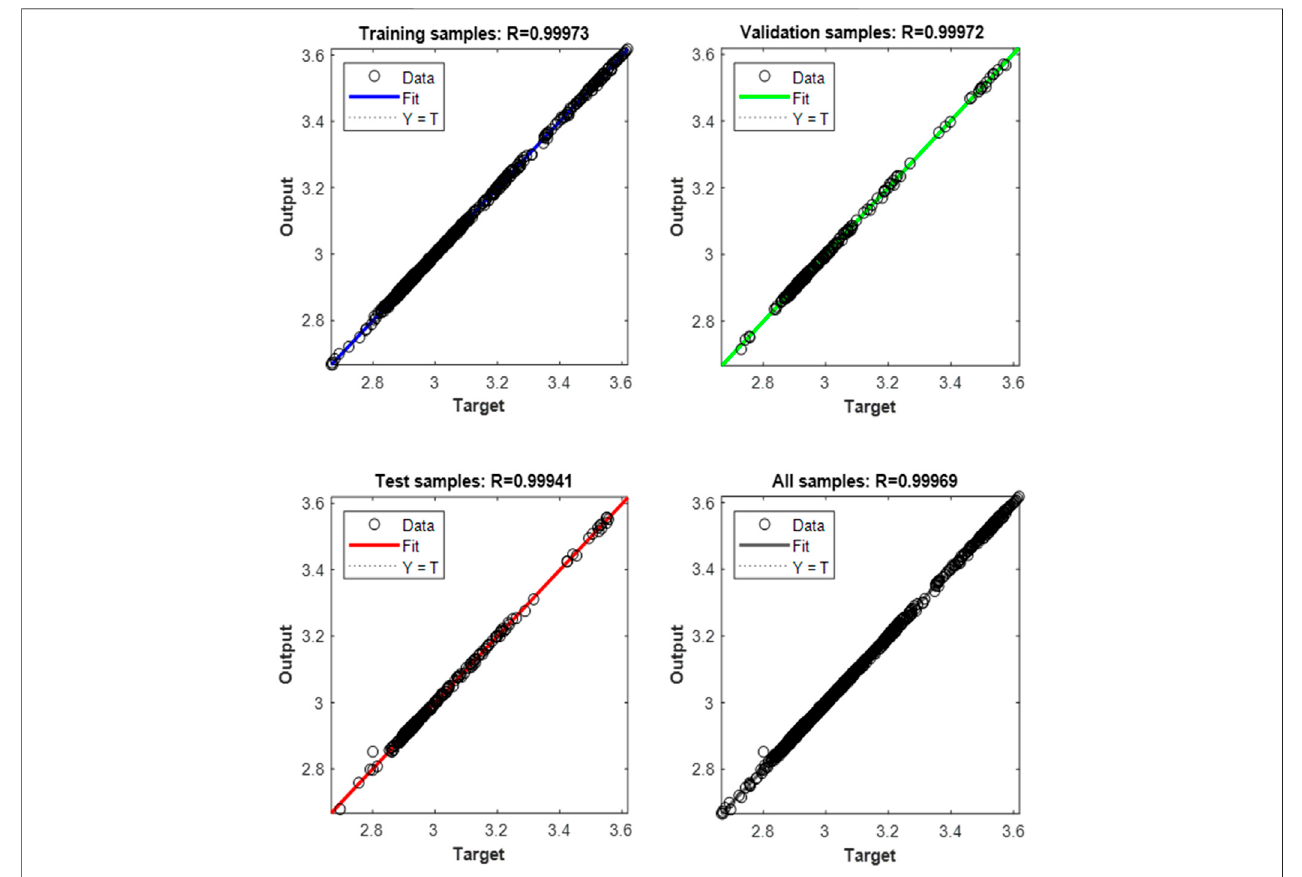
FIGURE 17 | Training results of the neural network